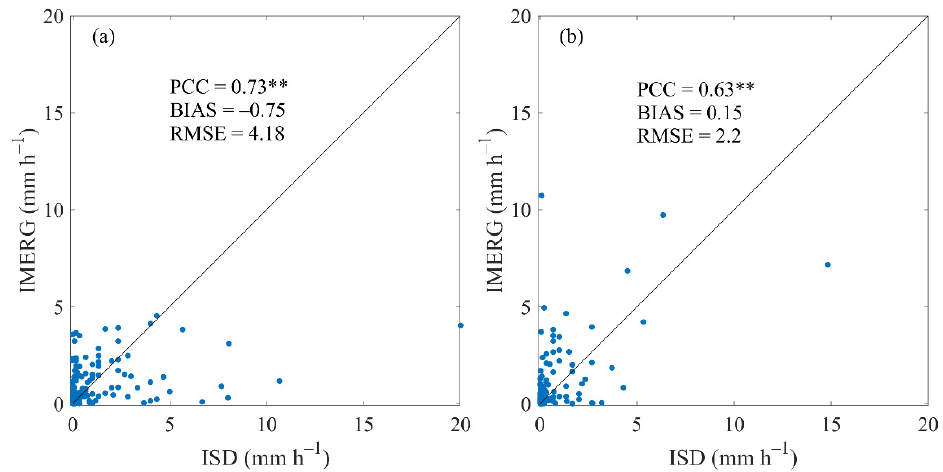
Figure 5. Statistics of PCC, BIAS, and RMSE from ISD and IMERG hourly precipitation (mm h − 1 ) at ( a ) Tabing and ( b ) Japura Airport during January and February 2018. The PCC values are significant at the 0.01 level according to the Student ′ s t -test (marked with “**”).